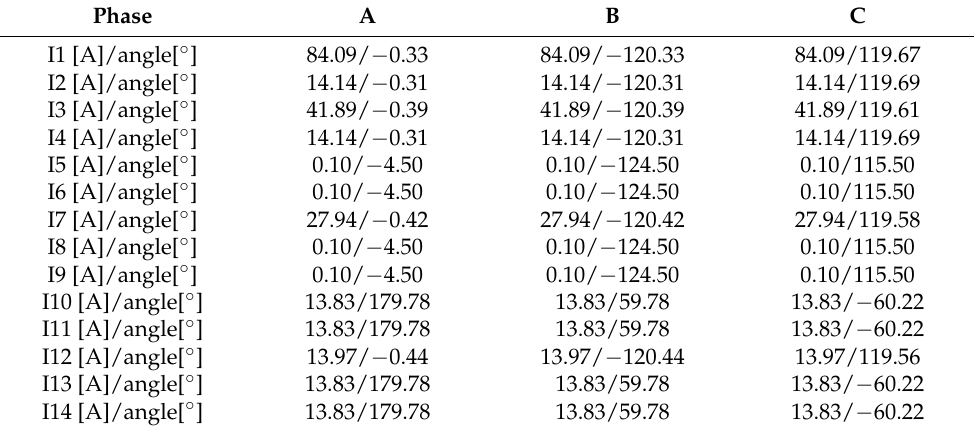
Table 2. The Load Flow Results.